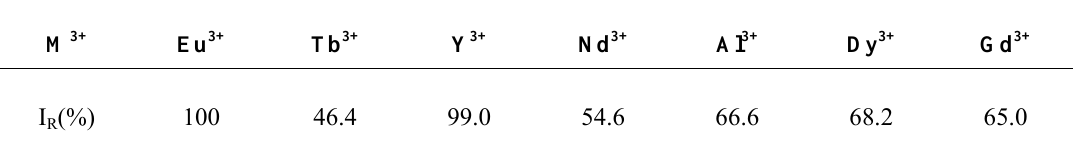
Table 2 . Effect of different rare earth ions on RLS intensity of Eu 3+ -nicotinic acid-fsDNA. M 3+ Eu